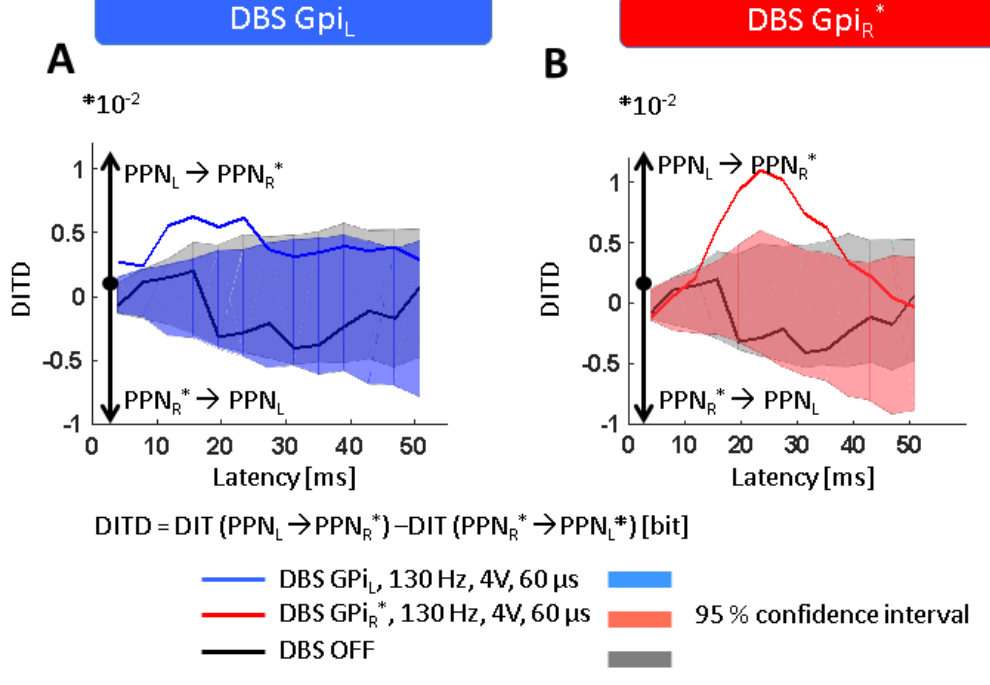
Figure 4. Effects of GPi-DBS on information exchange. Data are presented as differences in directed information transfer (DIT), i.e., values greater or smaller than zero indicate opposite directions of information flow as indicated on the diagrams, and DIT magnitude gives the amount of information exchanged in bits. Shaded areas give the 95% confidence interval of the DIT estimates after time-shuffling one of the two signals (leading to zero coupling), i.e., only DIT values outside the CI can be considered significantly different from zero. ( A , B ) While no exchange of information is observed between both PPNs during DBS-OFF, DBS of either GPi L or GPi R * induces a significant flow of information directed from PPN L to PPN R *. Abbreviations: CI: confidence interval, DBS: deep brain stimulation, DIT: directed information transfer, GPi: globus pallidus internus ( L = left, R = right, *denotes clinically more affected side), PPN: pedunculopontine nucleus region ( L = left, R = right, *denotes clinically more affected side).